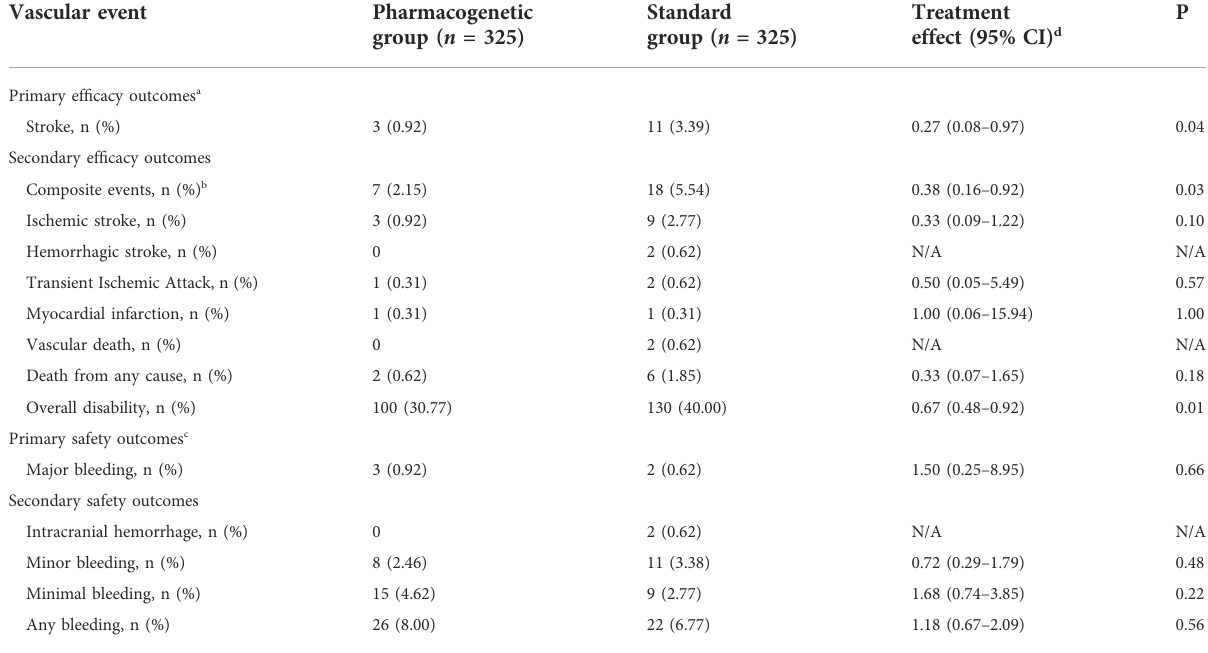
TABLE 3 Effect of the pharmacogenetic group and standard group on ef fi cacy and safety outcomes within 3 months.